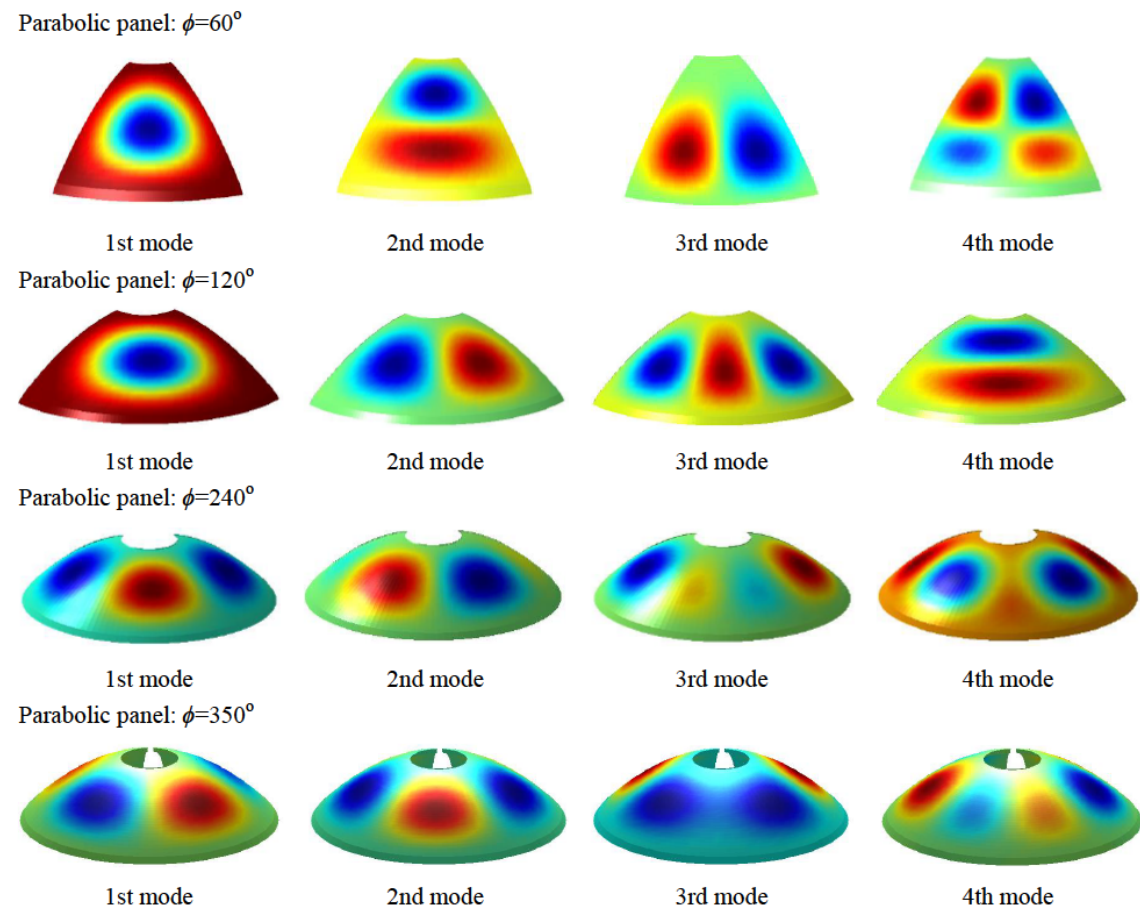
Figure 5: Mode shapes of the parabolic panel with CE 1 CE 1 boundary condition.